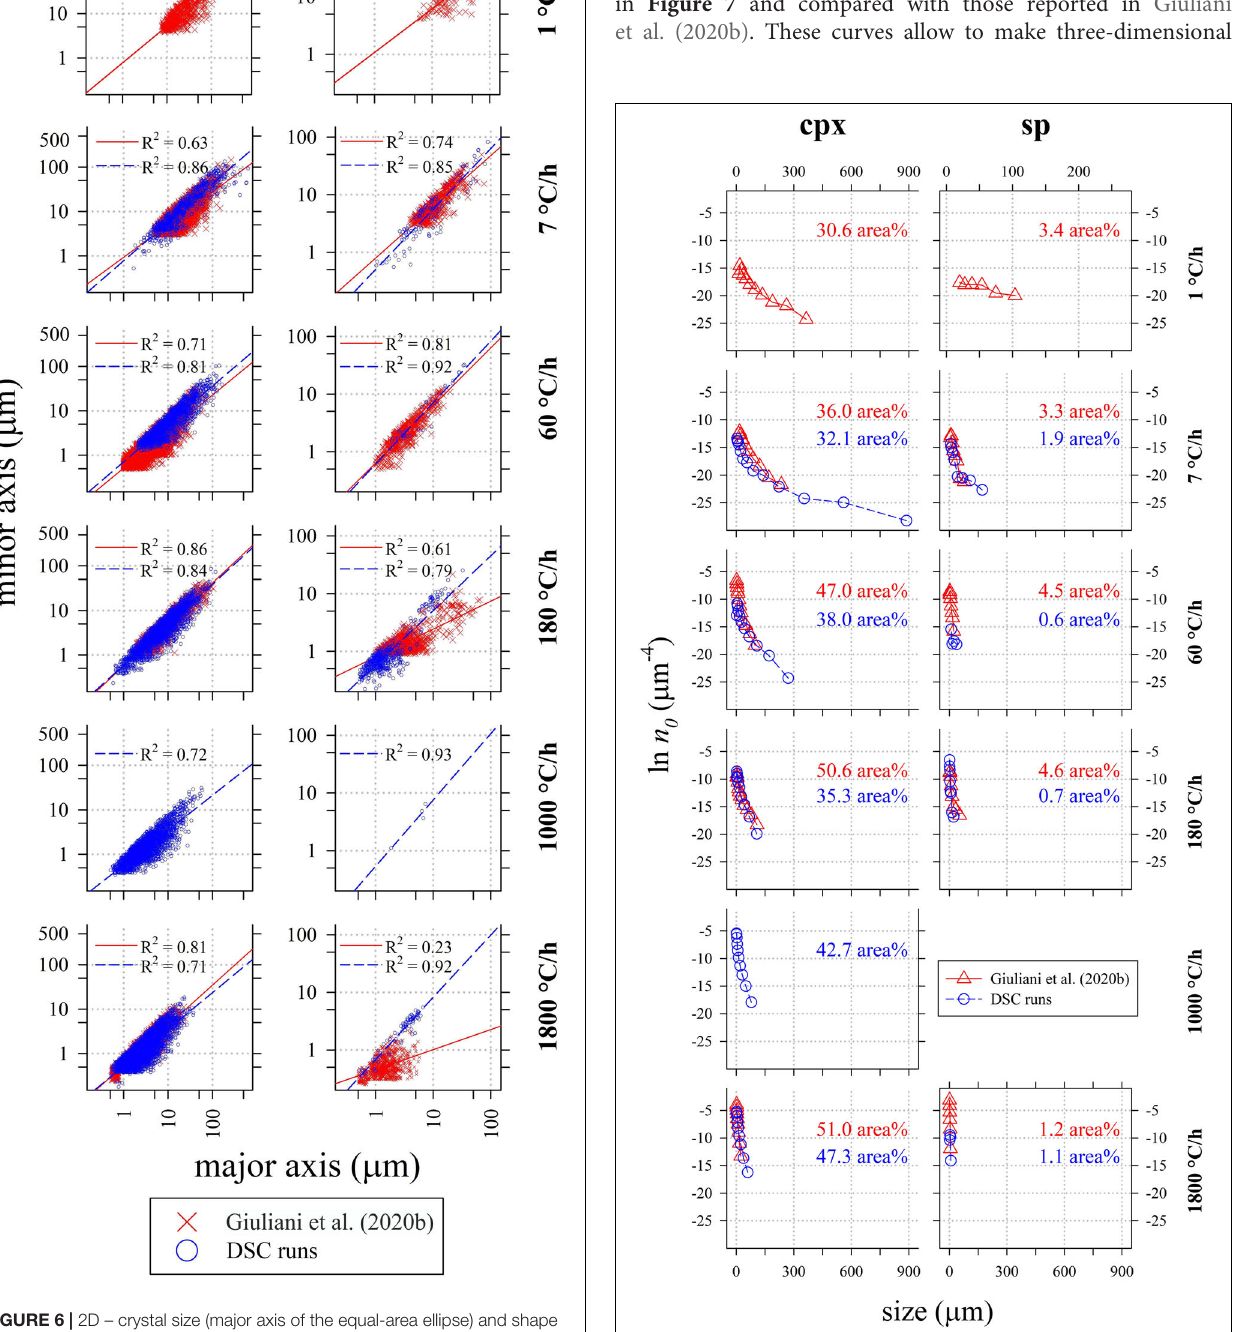
FIGURE 6 | 2D – crystal size (major axis of the equal-area ellipse) and shape (slope of the linear regression) of cpx (left column) and sp (right column) from in situ DSC experiments as a function of (cid:49) T / (cid:49) t . Data from Giuliani et al. (2020b) are also reported for comparison. The maximum, minimum, and average size for each experiment are listed in Table 5 .